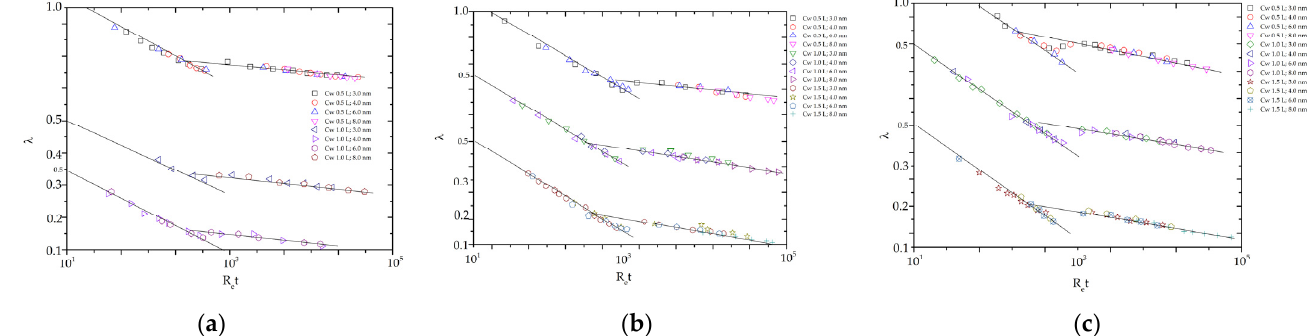
Figure 5. Comparison of friction factor to Reynold number of three kinds of solid suspension: ( a ) carbon; ( b ) SiO 2 ; and ( c ) kaolin with different granular size.